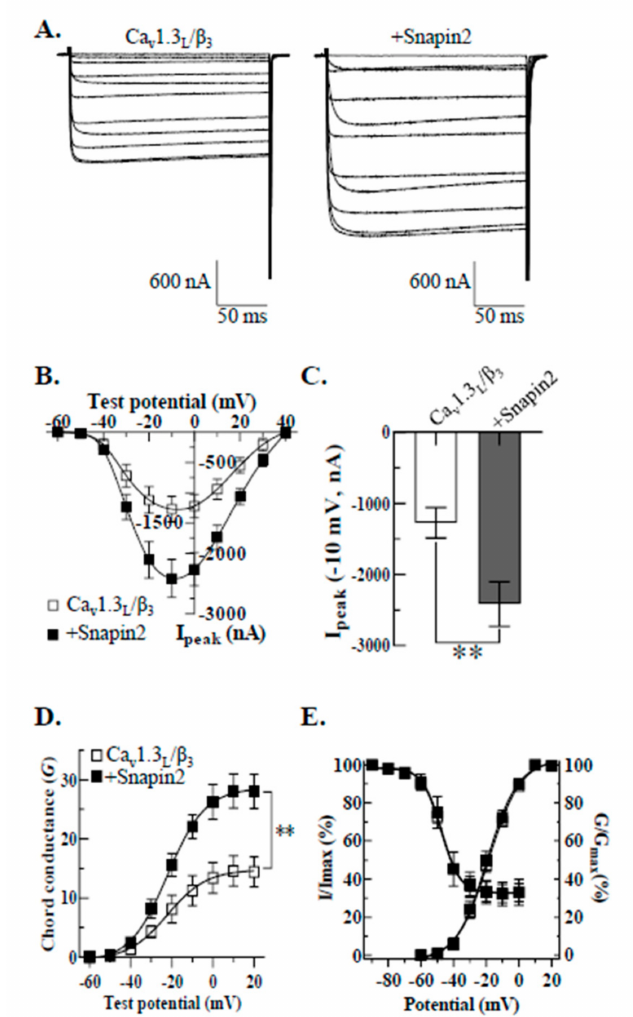
Figure 3. Snapin2 co-expression up-regulated Ca v 1.3 L channel activity in Xenopus oocytes. ( A ) Representative current traces of Ca v 1.3 L and Ca v β 3 co-expressed without (left) or with Snapin2 (right) recorded in 10 mM Ba 2+ solution. Current traces were evoked by an I-V protocol consisting of 200-ms depolarizing step pulses from − 60 mV to +40 mV from a holding potential of − 80 mV. ( B , C ), I-V relationships of Ca v 1.3 L channels without or with Snapin2. ( B ) Average peak current amplitude values of Ca v 1.3 L without ( (cid:3) ) or with Snapin2 ( (cid:4) ) were plotted against test potentials (n = 20–23). ( C ) The average peak current amplitude values of Ca v 1.3 L channels at − 10 mV test potential are represented as bar graphs ( − 1271.1 ± 214.1 vs. − 2414.5 ± 314.6 nA; n = 20–23; Student’s unpaired t -test, p < 0.01, **). ( D ) Chord conductance of Ca v 1.3 L channels co-expressed without ( (cid:3) ) or with Snapin2 ( (cid:4) ). Snapin2 co-expression enhanced about 1.9-fold the maximum chord conductance values (14.6 ± 2.6 vs. 28.1 ± 2.9 nS; n = 20; Student’s unpaired t -test, p < 0.01, **). ( E ) Snapin2 effect on voltage-dependent channel activation and channel availability of Ca v 1.3 L channels. The chord conductance values of Ca v 1.3 L channels without ( (cid:3) ) or with Snapin2 ( (cid:4) ) were normalized to the maximal chord conductance and superimposed. A similar two-step pulse protocol was applied to evaluate channel availability of Ca v 1.3 L channels without ( (cid:3) ) or with Snapin2 ( (cid:4) ). Normalized data for channel availability were plotted against pre-pulse potentials, and the smooth curves were from fitting the data to the Boltzmann equation (n = 20 for activation, n = 17 for channel